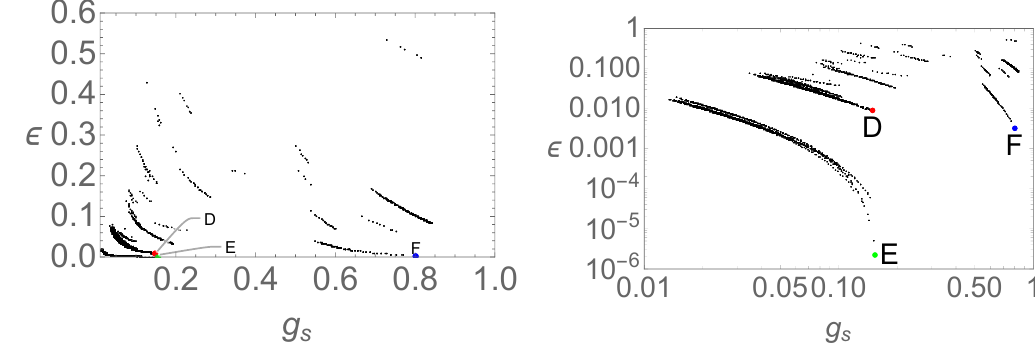
Figure 3 . Numerical results for the distribution of non-supersymmetric F-theory (cid:13)ux vacua. Each dot represents a solution with di(cid:11)erent set of (cid:13)uxes and the ambiguity from SL(2, Z ) duality has been deducted. Note that, as in (cid:12)gure 1, these dots can be degenerated in this 2D plot, due to the existence of other directions of the stabilized moduli z and z 1 . The right (cid:12)gure is the log-log plot of the same